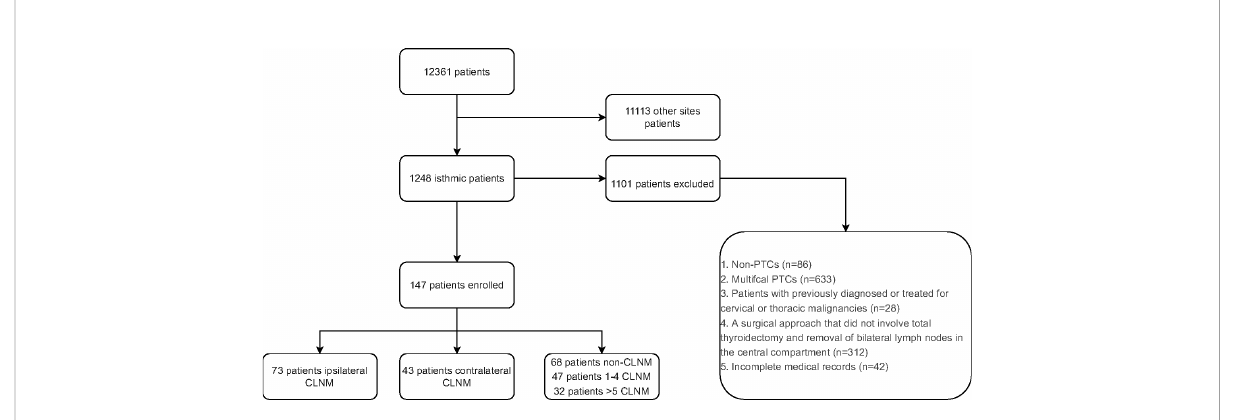
FIGURE 1 Flow chart of patient inclusion process. PTC, Papillary thyroid carcinoma; CLNM, central lymph node